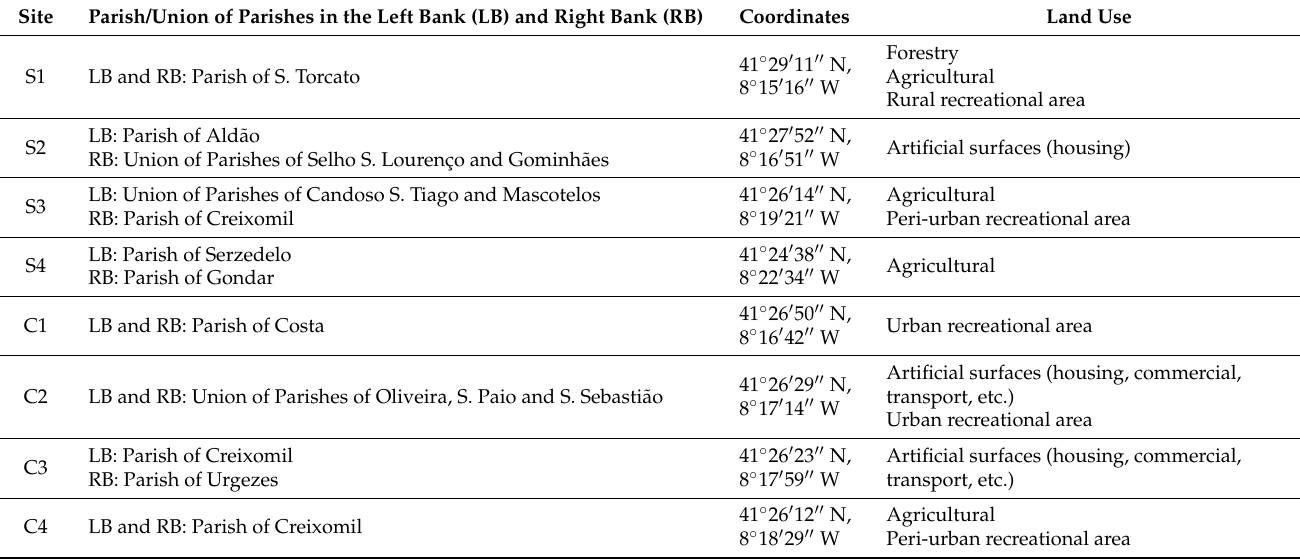
Table 1. Sampling sites of the Selho (S1 to S4) and Costa-Couros (C1 to C4) rivers, their location (Parish or Union of Parishes in Guimar ã es municipality), and land use near river